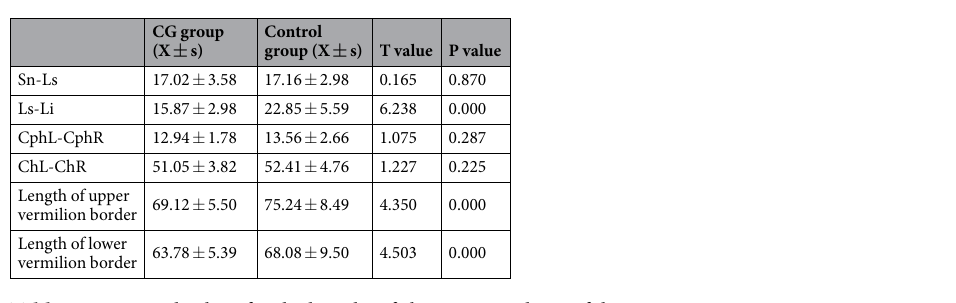
Table 4. Statistical values for the lengths of characteristic lines of the two